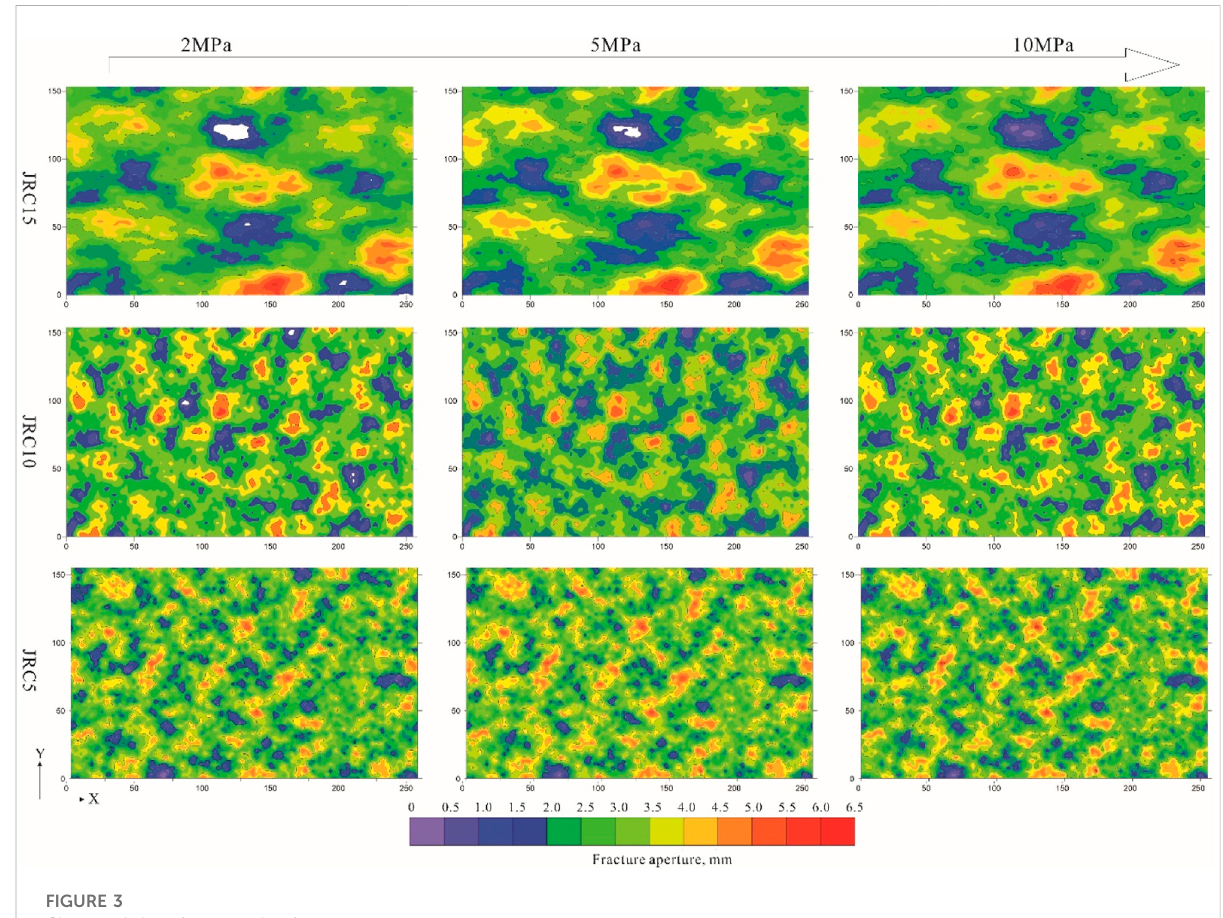
FIGURE 3 Characteristics of propagating